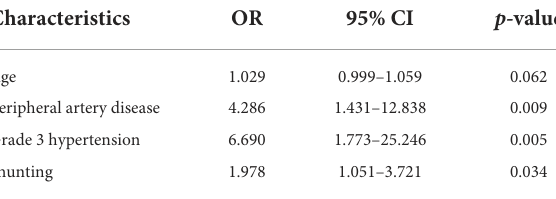
TABLE 3 Multivariate logistic regression of independent risk factors of hypotension during CEA